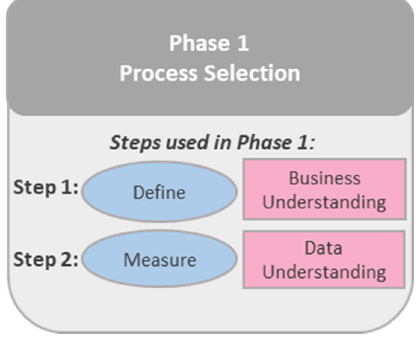
Figure 5. Combined methodology—Phase 1.